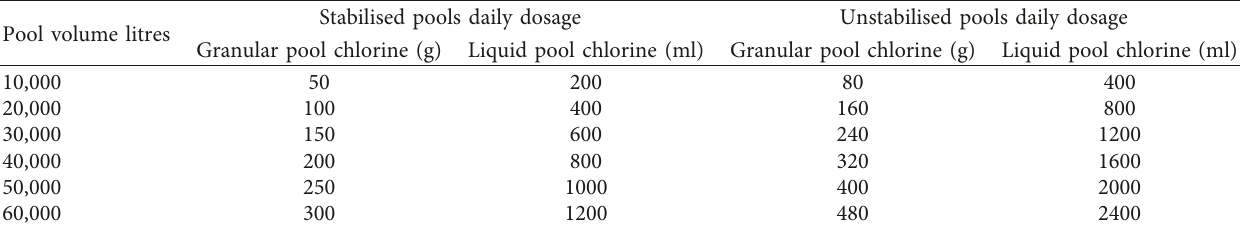
Table 1: The amount needed per swimming pool size [22].